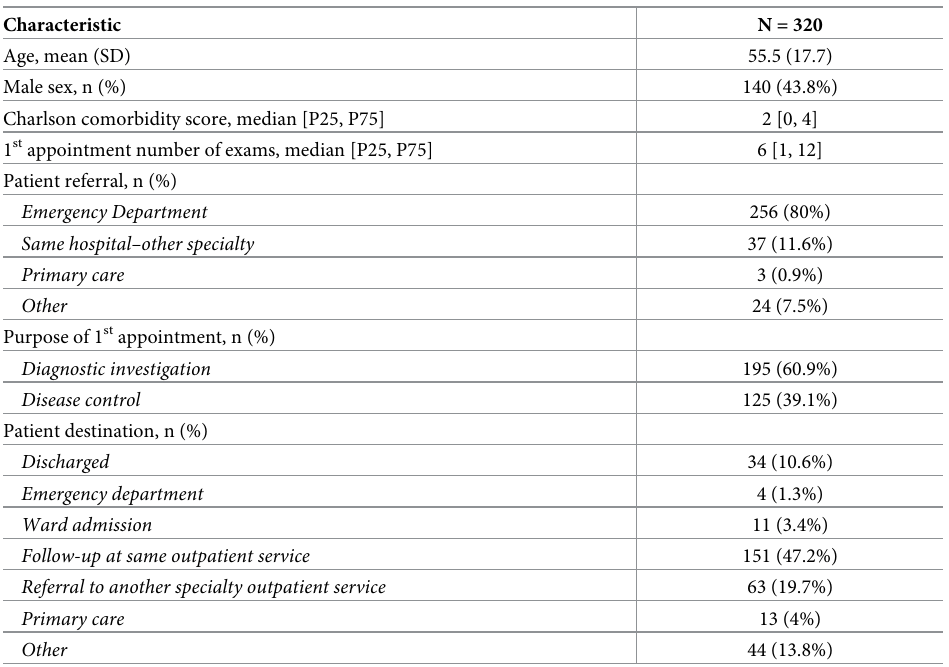
Table 1. Baseline patient characteristics.